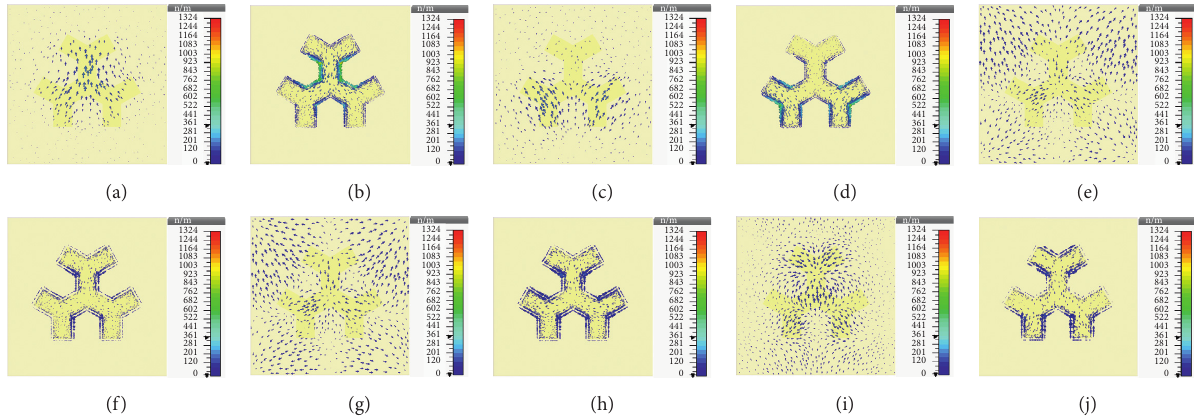
Figure 6: Surface current distribution for different peaks: (a) 5.984GHz, (c) 12.232GHz, (e) 18.128GHz, (g) 18.414 GHz, and (i) 20.592GHz for underlying metal and (b), (d), (f), (h), and (j) for top metal.